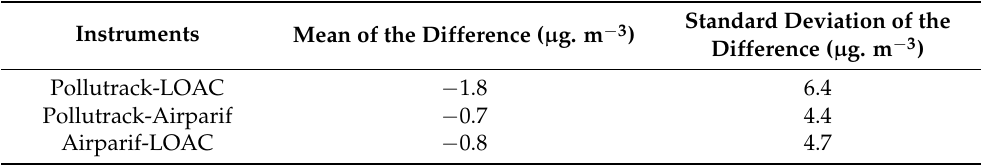
Table 2. Statistics of the differences between the 3 sets of measurements for the PM10.